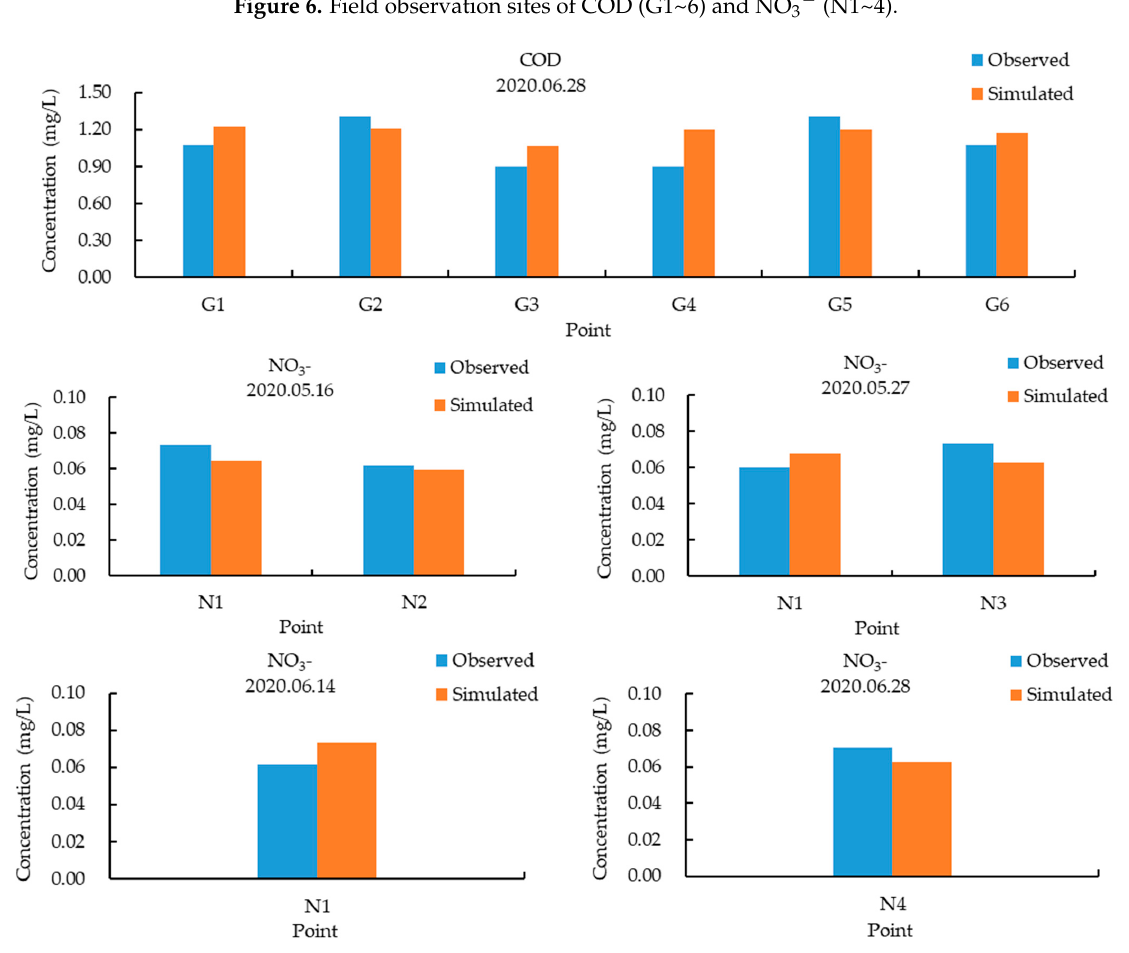
− based on the observed data in 3